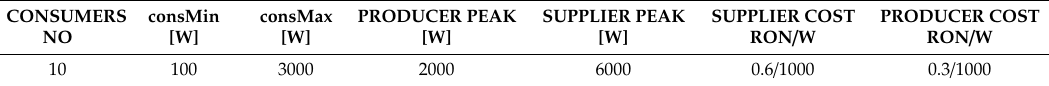
Table 3. Set of parameters from the simulator used for measurements presented